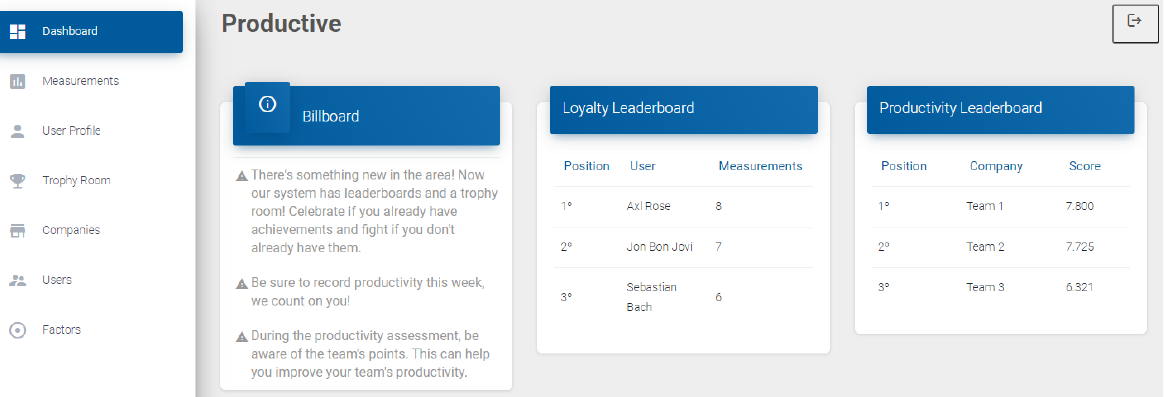
Figure 4. Dashboard